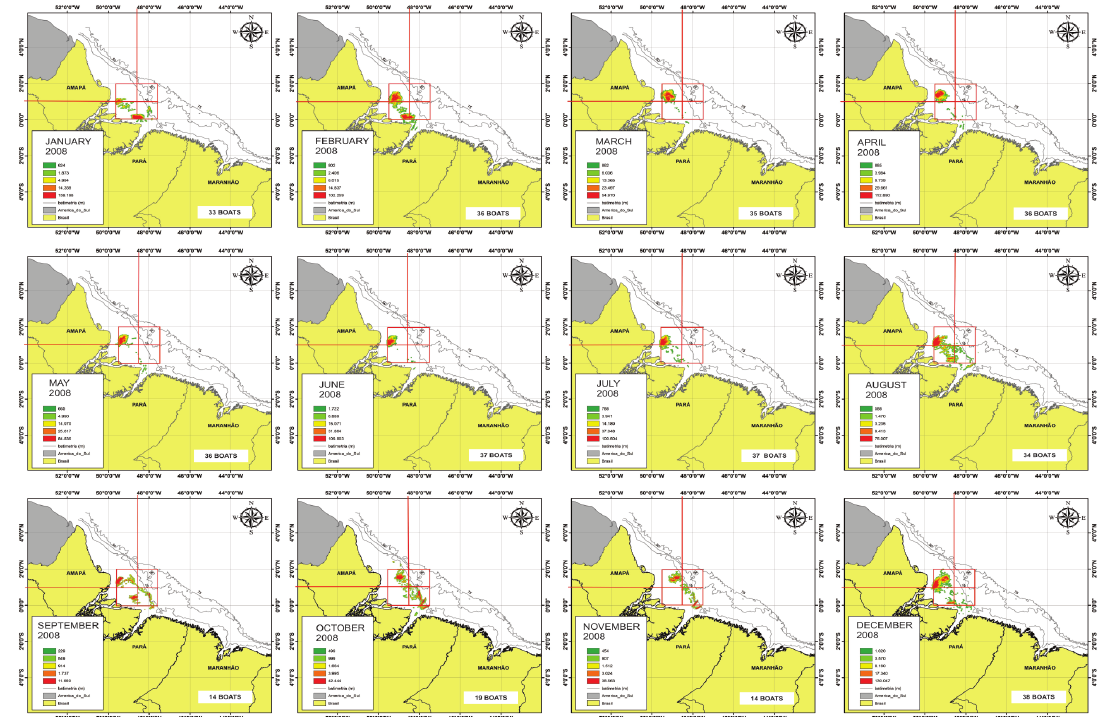
Figure 7. Relative density of fishing activity during the months of 2008 and fishing fleet dynamics divided by quadrant.